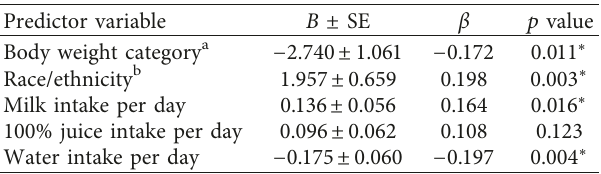
Table 4: Predictors of sugar-sweetened beverages intake (ounces) in WIC participating preschool-age